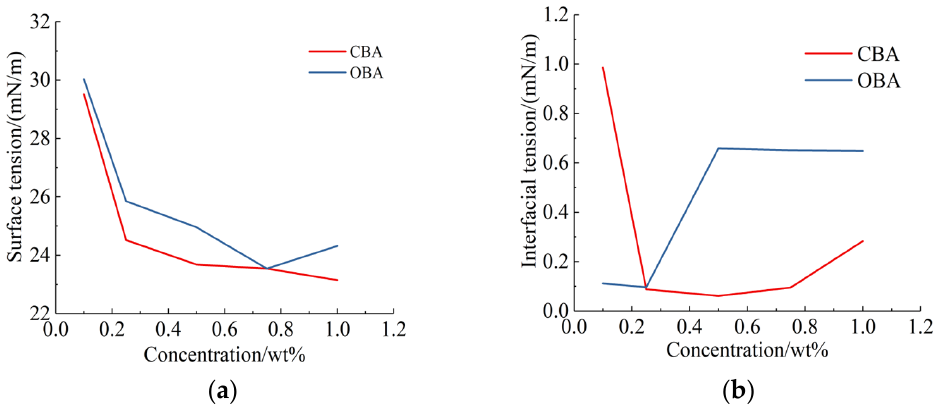
Figure 2. Surface/Interfacial tension of oil–displacement agents. ( a ) Surface tension; ( b ) interfacial tension.